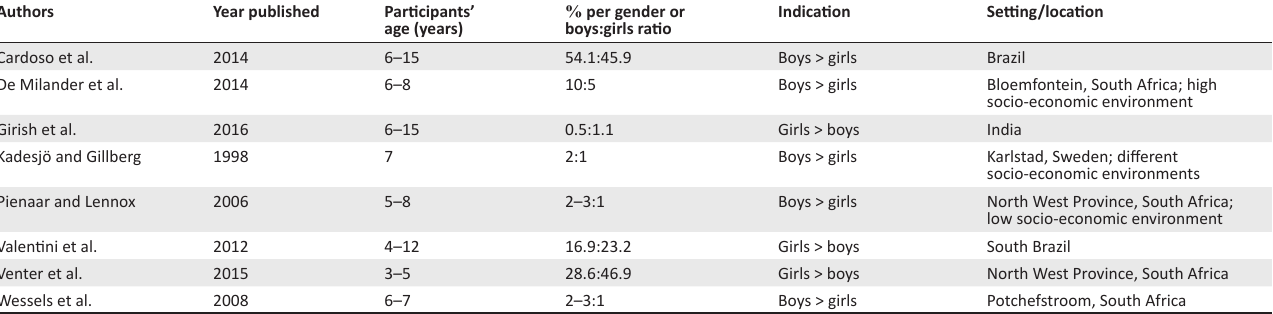
Indication Setting/location % per gender or age (years) boys:girls ratio